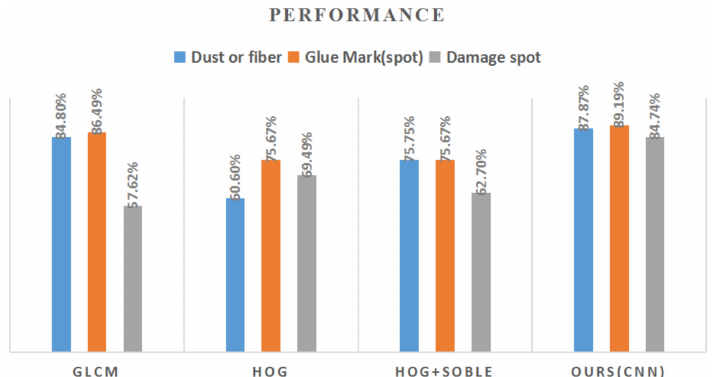
Figure 7. Detail classification results of four methods.